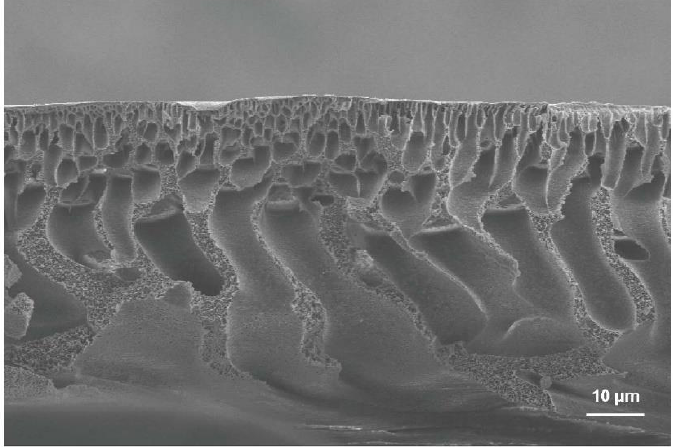
Figure3. Thetypicalcross-sectionalSEMimageofthePSmembranefabricatedbythephaseinversionprocess. Figure 3. The typical cross-sectional SEM image of the PS membrane fabricated by the phase inversion process.